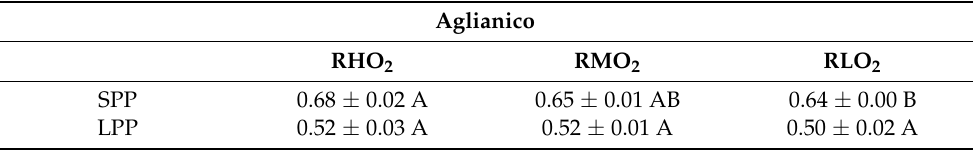
Table 4. Polymeric pigments (SPP) Short polymeric pigments and (LPP) Long polymeric pigments.